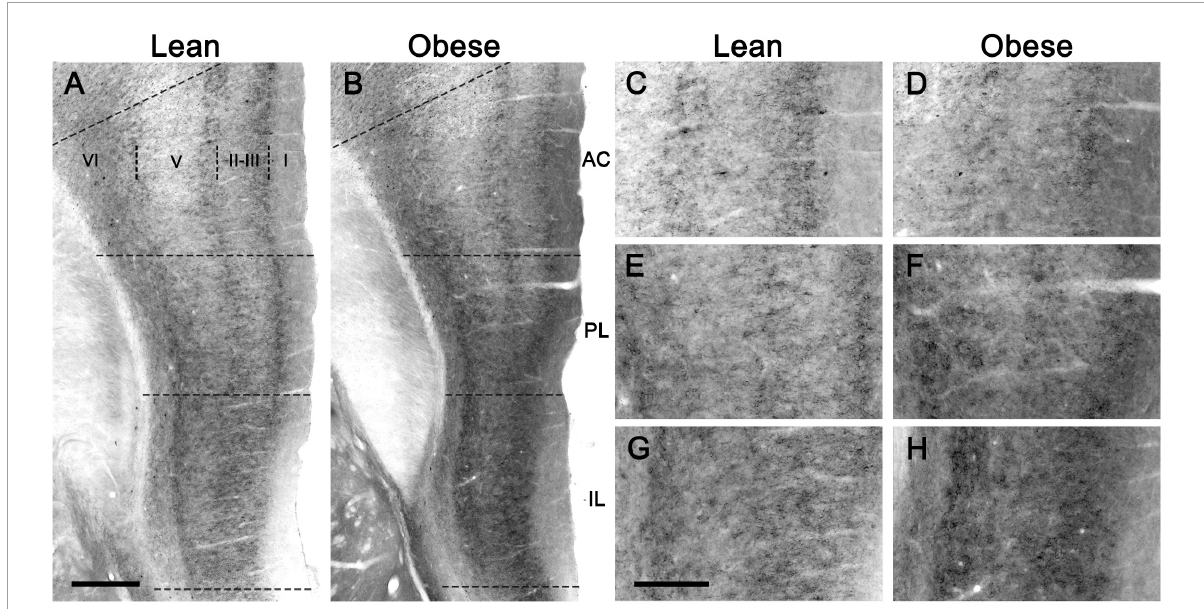
FIGURE3 CB 1 -immunostaining in the medial prefrontal cortex of lean and obese Zucker rats. (A,B) Low power micrographs showing the distribution of CB 1 -immunostaining in representative coronal sections of the medial prefrontal cortex of a lean (A) and an obese (B) Zucker rat. (C–E) Higher magnification micrographs of the sections shown in (A,B) , taken at the level of the anterior cingulate (C,D) , prelimbic (E,F), and infralimbic (G,H) cortices. All images were captured under the same conditions and processed in parallel. AC, anterior cingulate cortex; IL, infralimbic cortex; PL, prelimbic cortex. Scale bars = 200 µ m in (A) (applies to A,B ); 400 µ m in (G) (applies to C–H ).